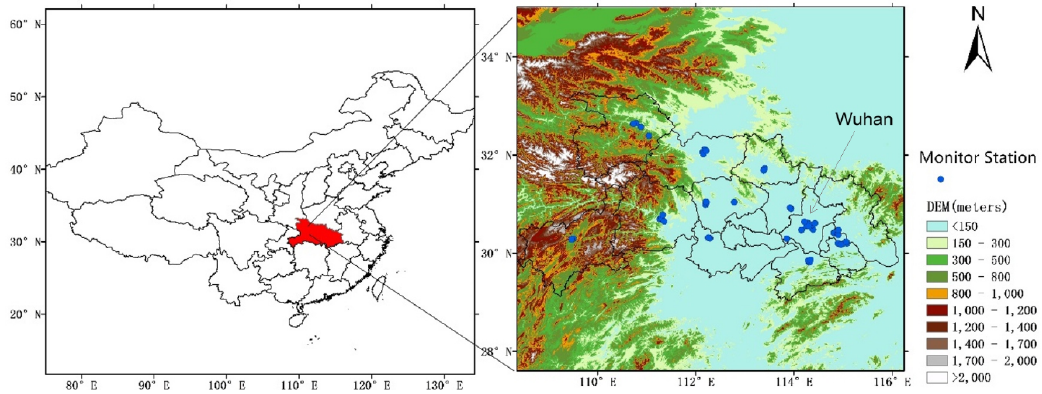
Figure 1. Terrain of central China and the ambient monitoring stations. DEM: Digital elevation model.